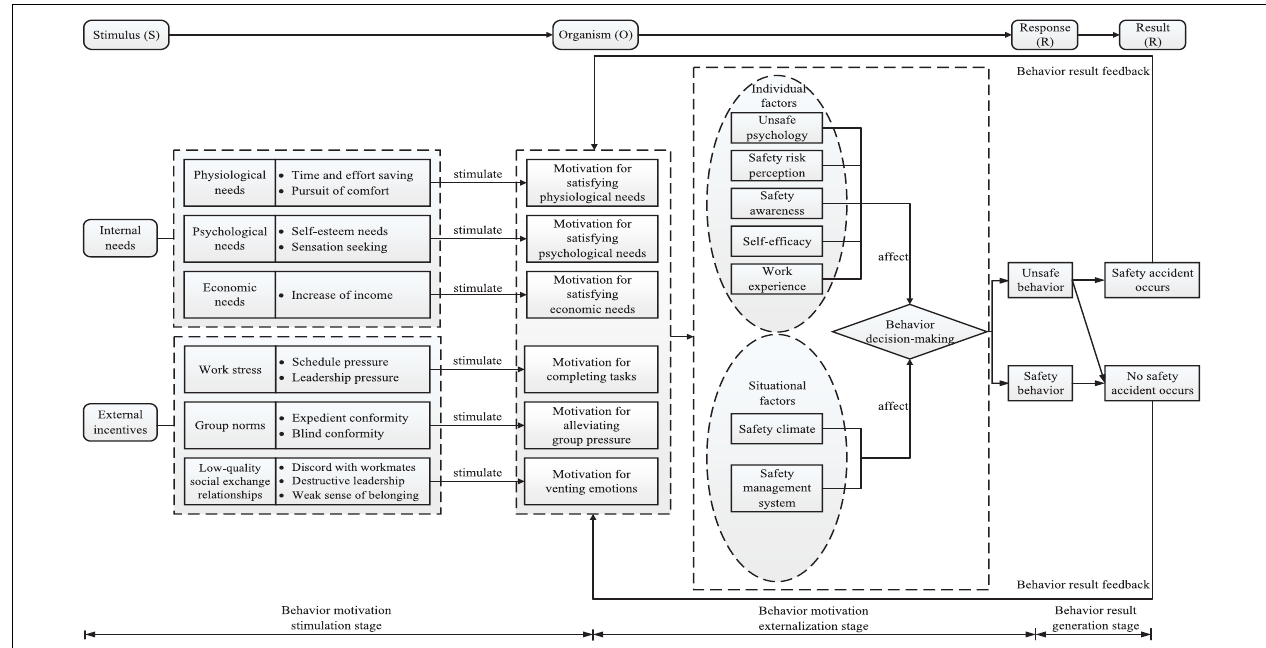
FIGURE 1 | Formation mechanism model of new generation of construction workers (NGCWs’) unsafe